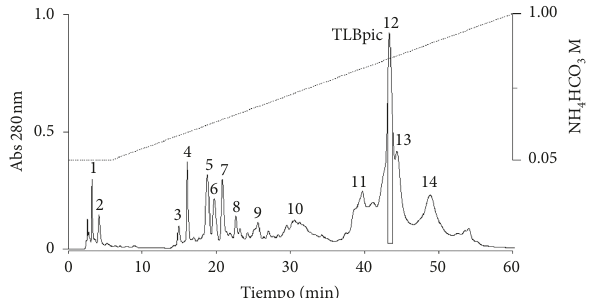
Figure 1: Ion exchange (cationic)